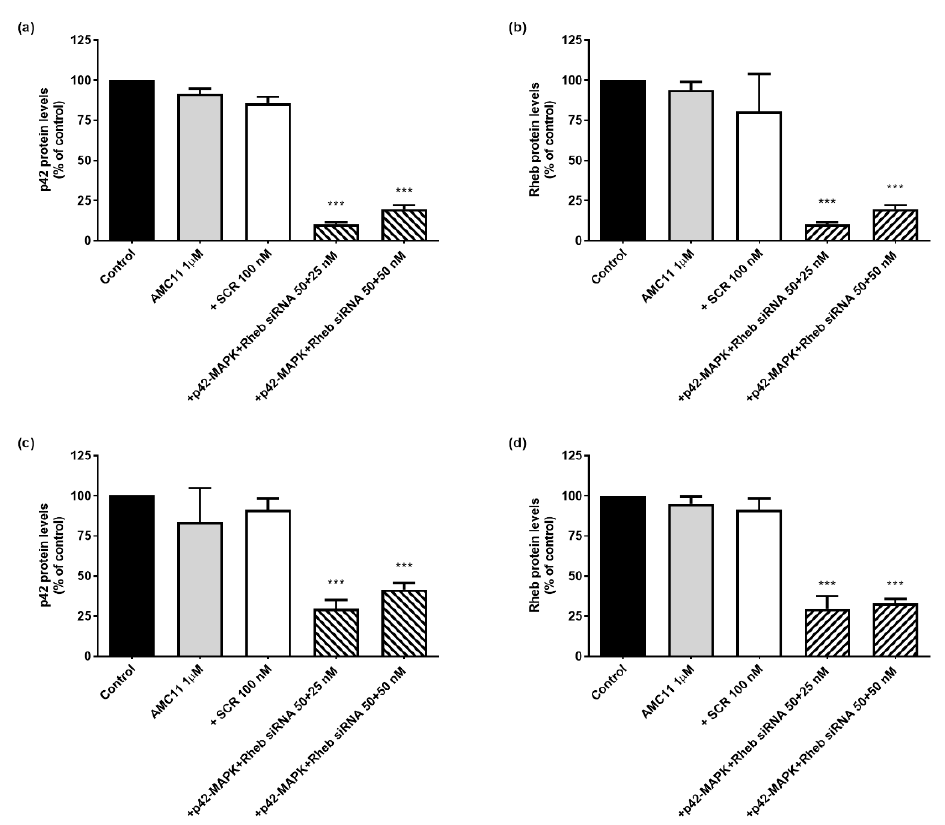
Figure 5. Simultaneous knockdown of p42-MAPK and Rheb in LNCaP and PC3 cell lines. ( a ) p42- MAPK protein levels in LNCaP cells, ( b ) Rheb protein levels in LNCaP cells, ( c ) p42-MAPK protein levels in PC3 cells, and ( d ) Rheb protein levels in PC3 cells. Cells were exposed for 72 h to the indicated treatments and the specific protein levels determined as indicated in Materials and Methods. Data represent mean ± SEM of 4 to 6 experiments *** p < 0.001 as compared to control values.